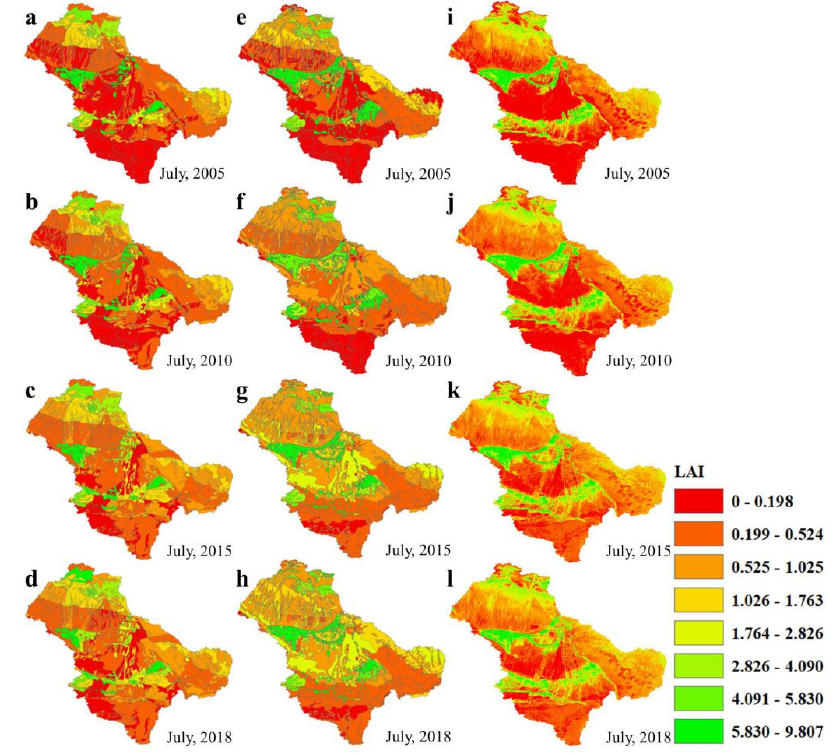
Figure 10. Simulated leaf area index (LAI) from the ( a – d ) calibrated original SWAT ‐ MODFLOW model, ( e – h ) calibrated LU ‐ SWAT ‐ MODFLOW model, and ( i – l ) remote ‐ sensed LAI. Table 4. Performance of the original SWAT ‐ MODFLOW model versus the LU ‐ SWAT ‐ MODFLOW model in simulating LAI. SWAT ‐ MODFLOW LU ‐ SWAT ‐ MODFLOW HRU Calibration Period Validation Period Calibration Period Validation Period NSE